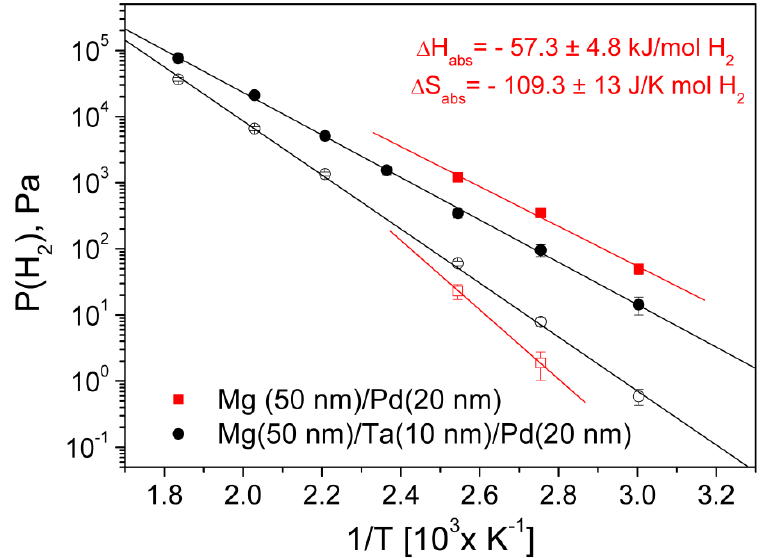
Figure 9. Van‘t Hoff plot of Mg films with (red squares) and without (black circles) a direct contact with Pd cap-layer. The error bars of the equilibrium pressure estimation are also